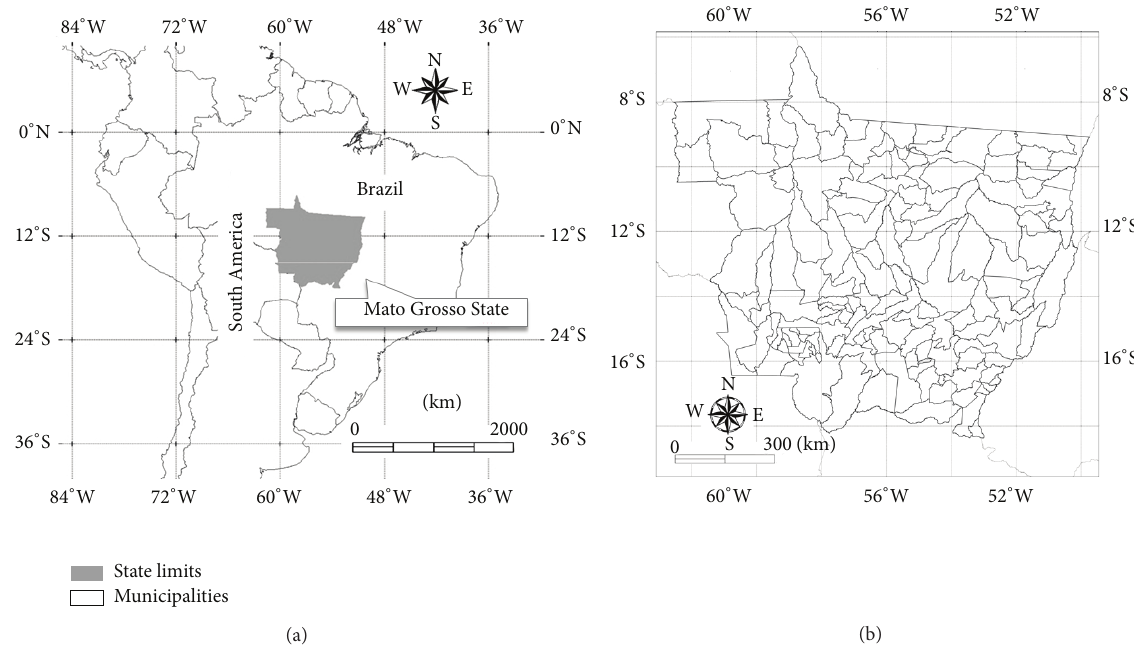
Figure 1: Mato Grosso State in Brazil and its 146